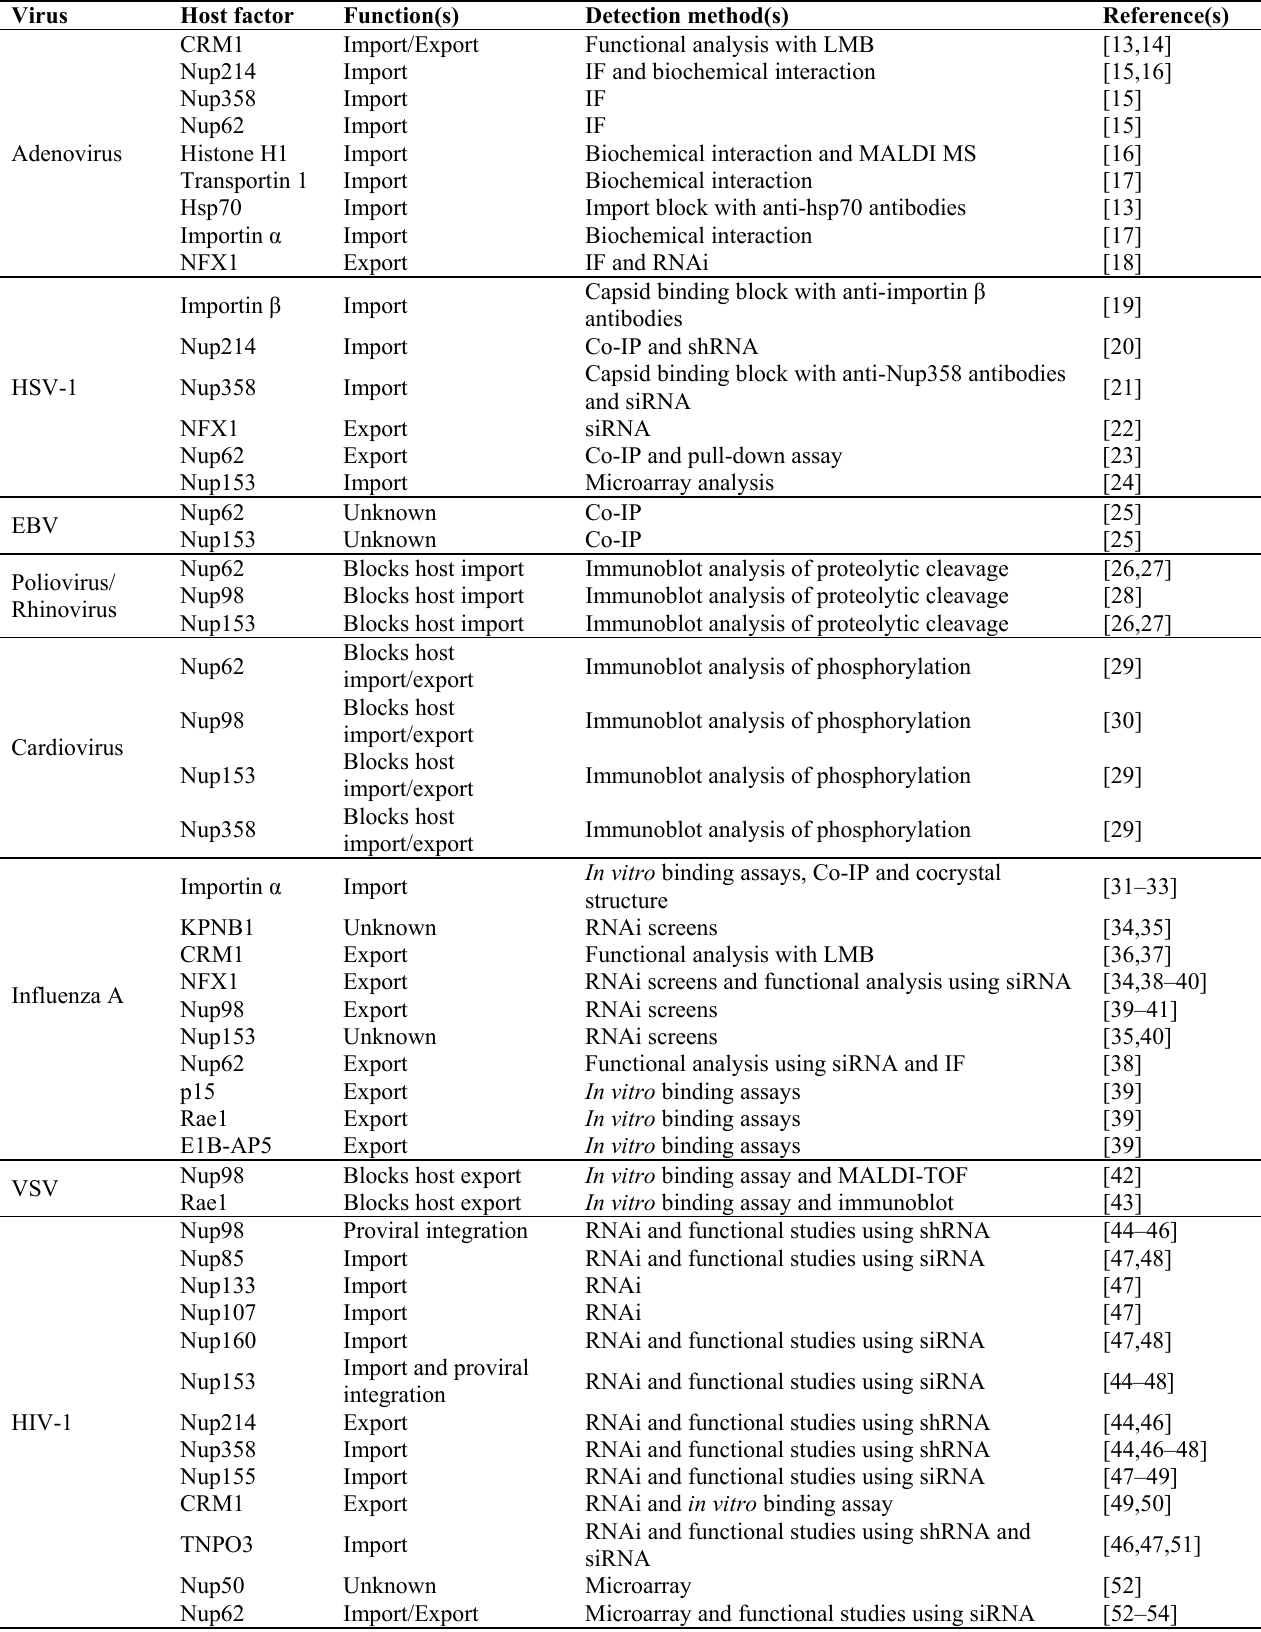
Table 1. Host factors subverted by different viruses to facilitate transport across the